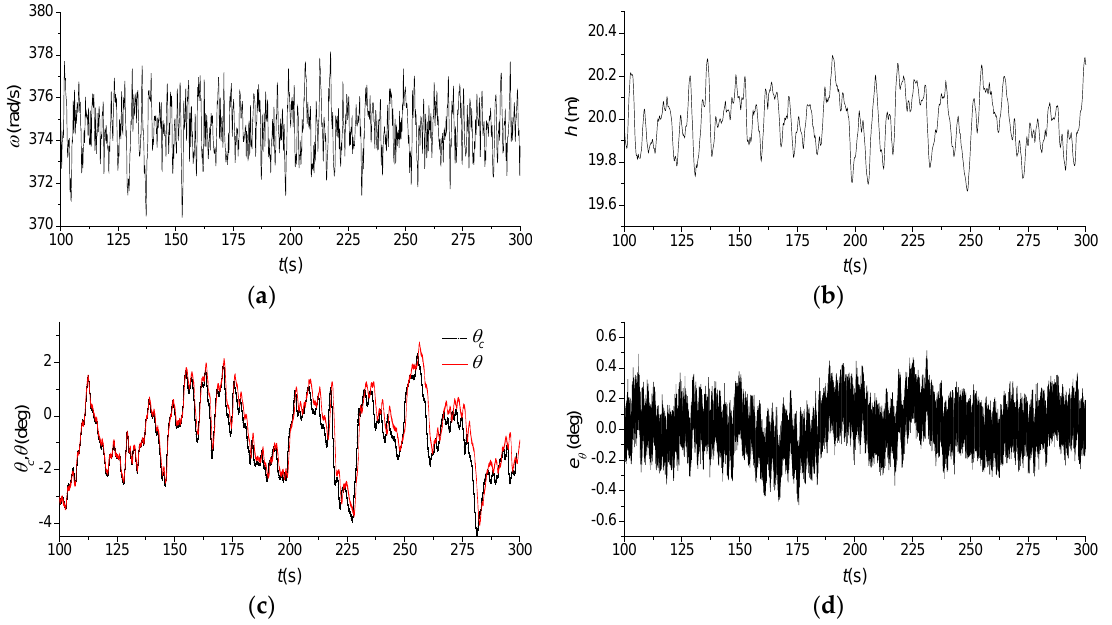
Figure 15. The experimental results using the PID controllers in the altitude loops, and the PID controller with the closed-loop rotational speed control structure in the altitude loop: ( a ) ω ; ( b ) h ; ( c ) θ c and θ ; ( d ) e θ